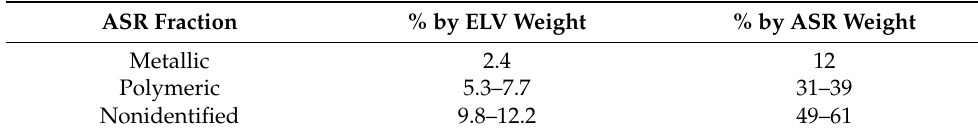
Table 1. Percentage by weight of the ASR fractions.